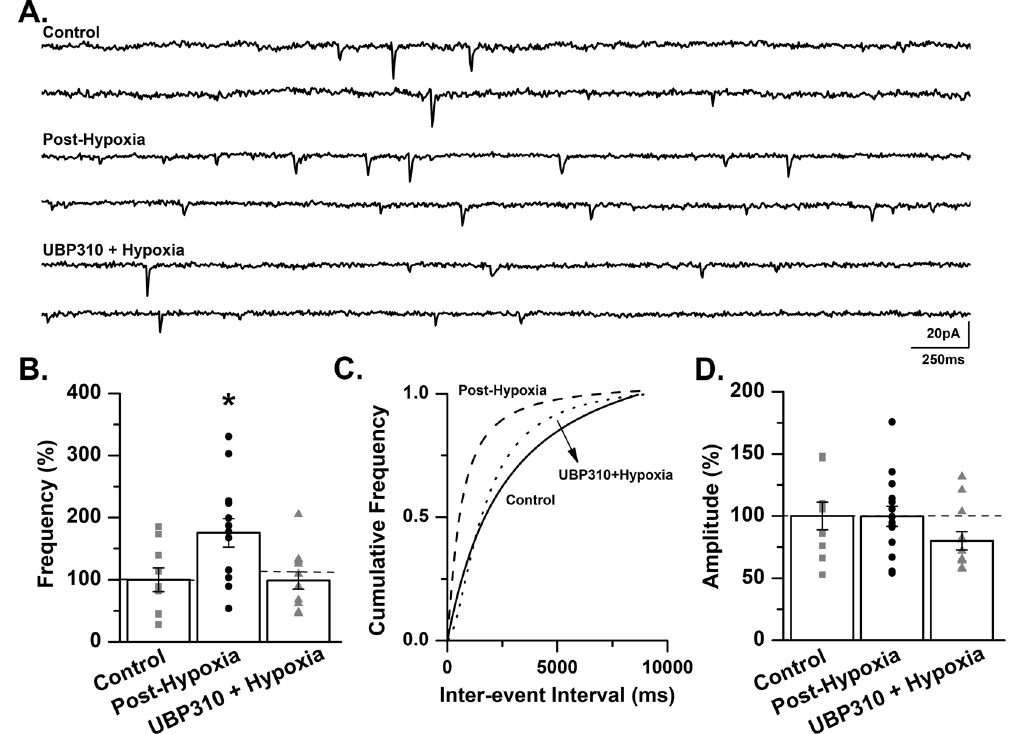
Figure 5. Treatment with UBP310 prevents the increase in mEPSC frequency following exposure to in vivo hypoxia in the neonatal mouse. ( A ) Representative traces from a control C57BL/6 mouse (Control), a mouse 1-hour post in vivo hypoxia (Post-Hypoxia) and a mouse exposed to in vivo hypoxia following treatment with 20 mg/kg UBP310 (UBP310 + Hypoxia). Traces demonstrate an increase in mEPSC frequency post-hypoxia with similar frequencies between control and UBP310-treated animals. ( B ) mEPSC frequency is significantly increased in CA3 pyramidal cells 1-hour post-hypoxia. Treatment with UBP310 prior to hypoxia prevents the increase in mEPSC frequency (control: 0.5 ± 0.1 Hz; post-hypoxia: 0.88 ± 0.12 Hz; UBP310 + hypoxia: 0.5 ± 0.07 Hz). * p < 0.05, K-W ANOVA. Data presented as percent mean ± SEM. ( C ) A representative inter- event cumulative frequency histogram demonstrating the significant increase in mEPSC frequency 1-hour post-hypoxia in CA3 pyramidal cells of the neonatal mouse. Control, solid line; Post-Hypoxia, dashed line; UBP310 + Hypoxia, dotted line. ( D ) No change in mEPSC amplitude was observed between groups (control: 14.2 ± 1.58 pA; post-hypoxia: 14.16 ± 1.15 pA; UBP310 + Hypoxia: 11.36 ± 1.04 pA). Control: n = 9 cells, 7 animals; Post-Hypoxia: n = 13 cells, 11 animals; UBP310 + Hypoxia: n = 12 cells, 9 animals. Data presented as percent mean ±